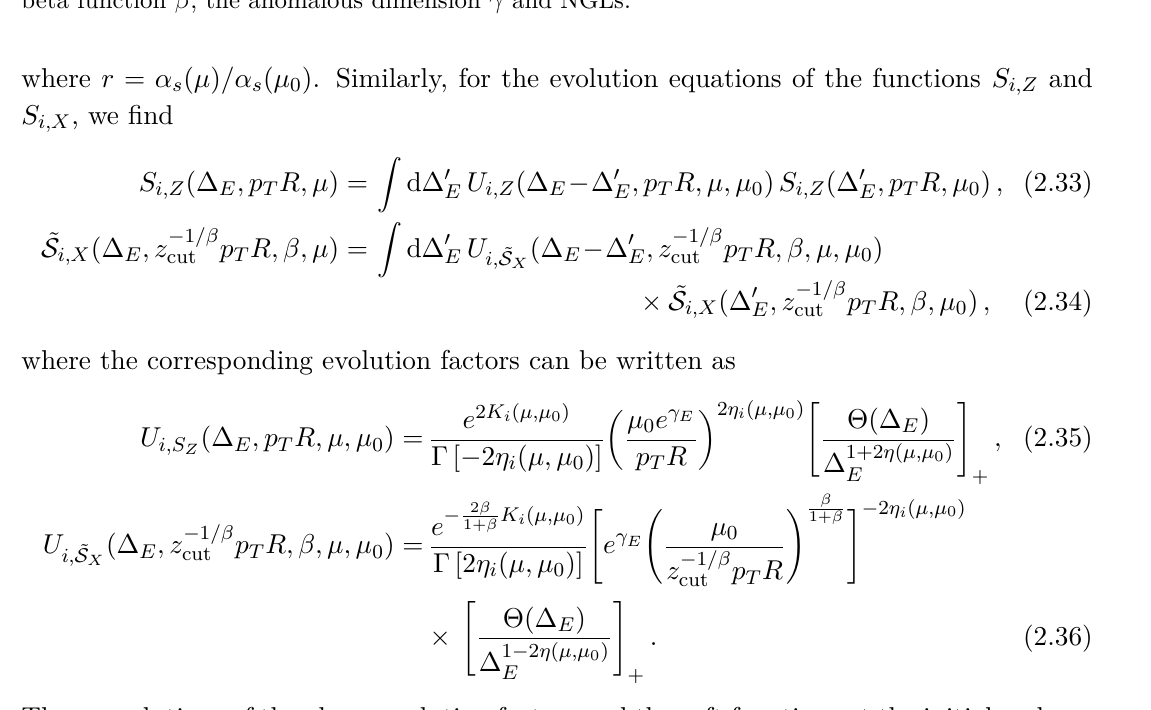
Table 2 . The required perturbative ingredients needed at different orders (rows) for the resumma- tion of logarithms of the jet radius R , jet energy drop ∆ E and grooming parameter z cut for iterated soft drop. The columns indicate the order of fixed-order ingredients in the factorization, the QCD beta function β , the anomalous dimension γ and